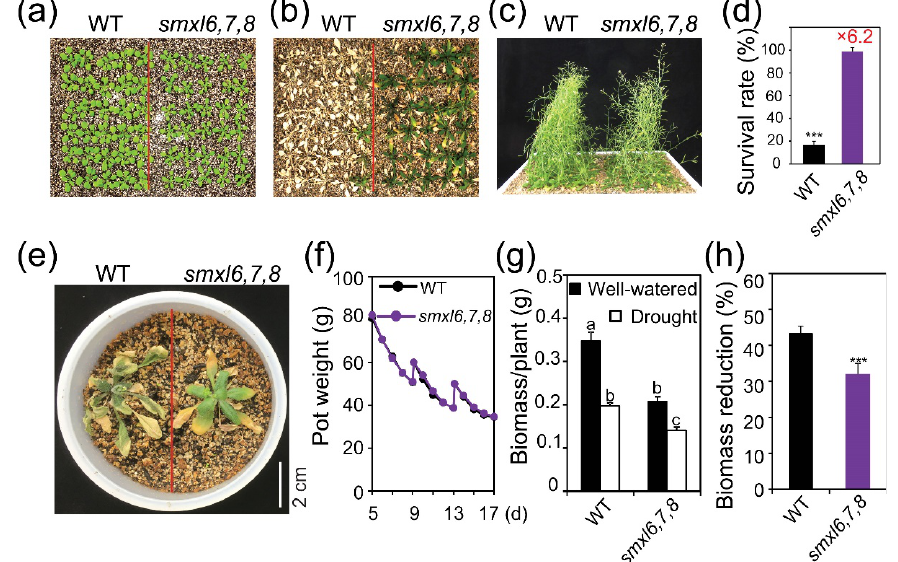
Figure 1. Enhanced drought resistance of smxl6 , 7 , 8 mutant plants. Comparisons of smxl6 , 7 , 8 mutant and wild-type (WT) plants were performed using the ‘same tray’ ( a – d ), ‘one pot’ ( e ) and ‘weighing’ ( f – h ) methods. ( a ) WT and smxl6 , 7 , 8 mutant plants were grown for 21 days under well-watered conditions in a tray. ( b ) Water was withheld to observe distinguishable differences between the two genotypes. After 15 days of water withholding, rewatering was conducted. A picture was taken five days after rewatering, and after inflorescences were removed. ( c ) Control well-watered plants were grown in parallel with the drought resistance assay. ( d ) Means and standard errors (SEs) of three independent experiments ( n = 3, 30 plants/genotype/experiment) were used to estimate the survival rates of investigated WT and smxl6 , 7 , 8 mutant plants. Red number above the error bar indicates the fold-change in survival rate of smxl6,7,8 mutant over the WT. ( e ) WT and smxl6 , 7 , 8 plants were grown side-by-side in a small pot. Water was withheld to observe distinguishable differences between the two genotypes. After 15 days of water withholding, rewatering was conducted. Picture was taken five days after rewatering, and after inflorescences were removed. ( f ) Pot weights during the soil-drying process of the ‘weighing’ method. Data are means and SEs ( n = 12 pots/genotype). ( g ) Shoot dry weights of WT and smxl6 , 7 , 8 mutant plants were measured at day 17th of the well-watered or drought treatment. ( h ) Shoot biomass reduction percentages of WT and smxl6 , 7 , 8 mutant plants at day 17th of the ‘weighing’ assay. Data are means and SEs ( n = 12 plants/genotype). Letters above the error bars indicate significant differences (Tukey’s honest significant difference test; p < 0.05). Asterisks show significant differences between the two genotypes (Student’s t -test; *** p < 0.001).